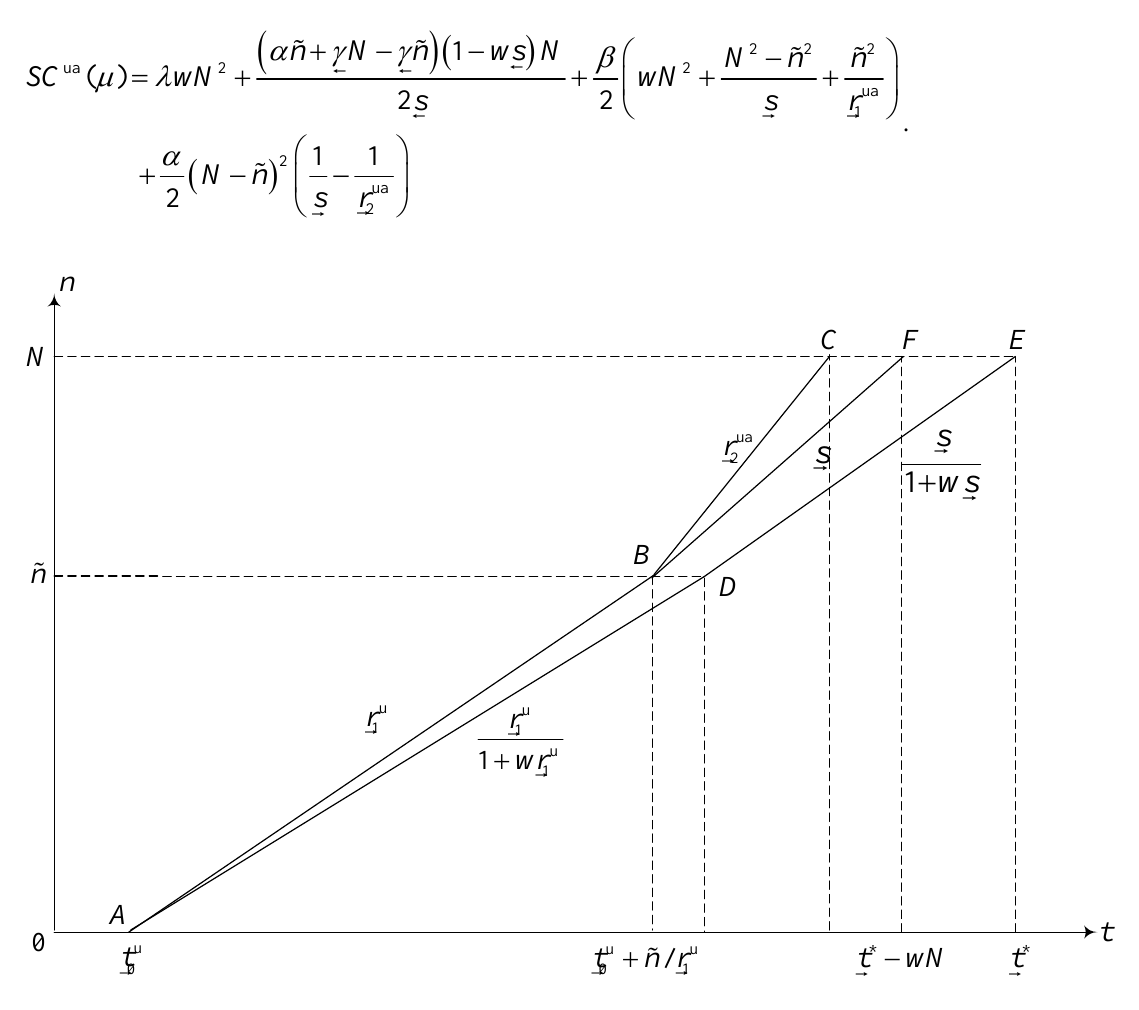
Figure 3. User equilibrium traffic pattern in the morning commute, regime u(a) The situation without queue is denoted as regime u(b). In this regime,